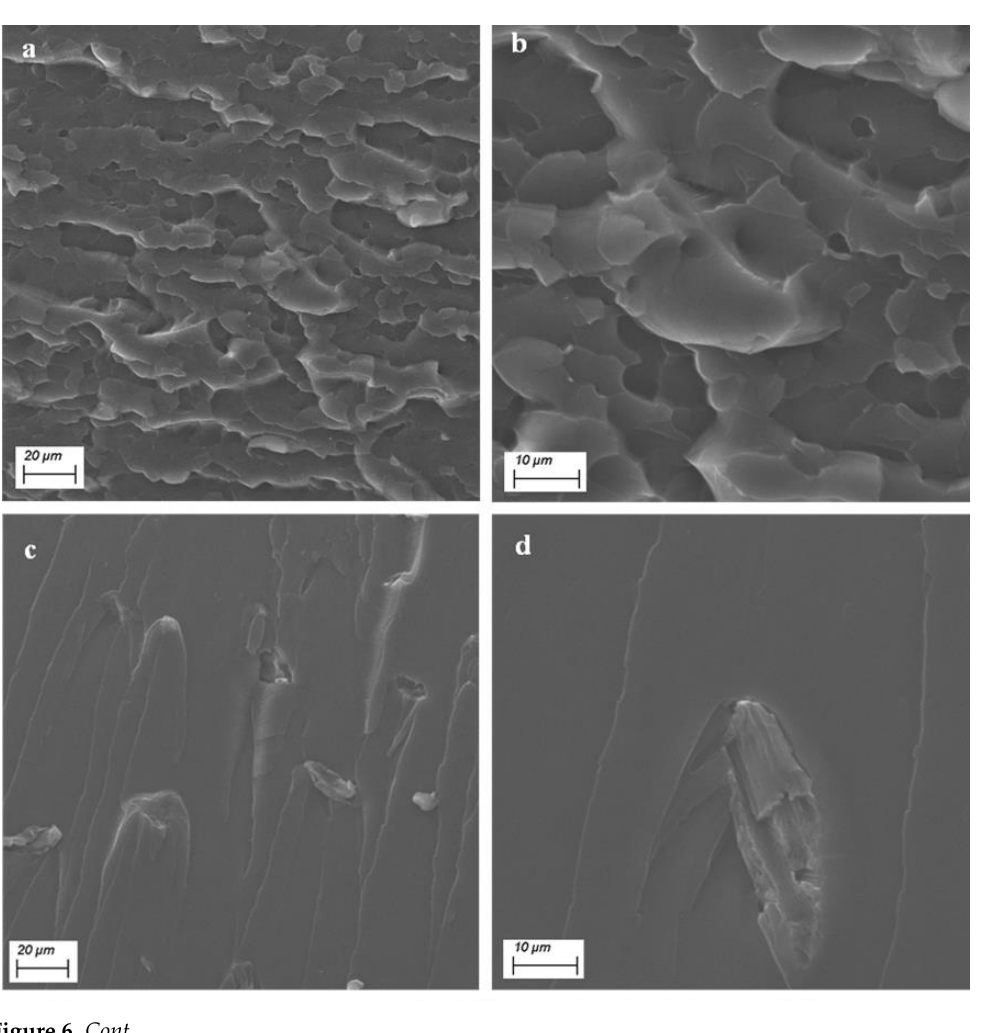
Figure 6. Typical SEM micrographs of ( a , b ) unfilled P.A.20:80 and samples containing 0.60 wt.% ( c , d ) MCC and ( e , f ) CNC. 3.2.5. Thermogravimetric Analysis Thermogravimetric analyses were carried out to assess the thermal and thermo-oxi- dative behavior of the different UV-cured systems. Table 5 presents the obtained data for the 3D-printed unfilled systems investigated as a function of AESO content; Tables 6 and